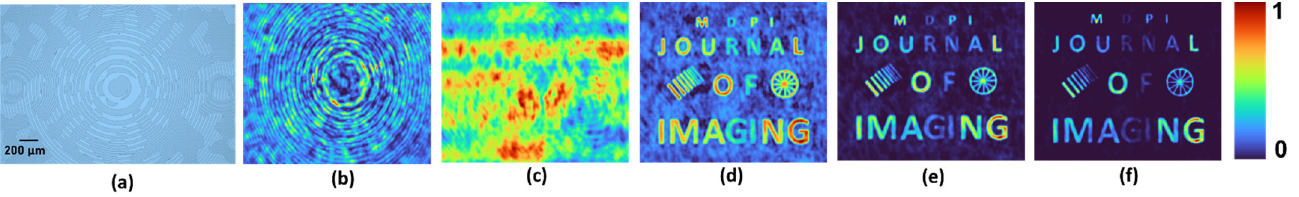
Figure 16. ( a ) Phase image of the multifunctional DOE. ( b ) Recorded PSF, ( c ) object’s response pat- tern. Reconstruction results using ( d ) NLR ( p = 1), ( e ) NLR ( p = 2) and ( f ) NLR ( p = 3) for double- helix beam with rotating PSF. 5. Discussion and Conclusions The optical fields that were simulated and experimentally generated in the previous sections are widely used for various applications such as optical trapping (Laguerre– Gaussian beams), 3D fabrication (Bessel beam), corneal surgery (Lens–axicon pair) and imaging through occlusion and turbid media (Bessel and accelerating Airy beams). Most, if not all, the light–matter interactions have been observed using another optical channel, which is the imaging channel. The proposed direction of research using the above deter- ministic optical beams in an indirect-imaging framework may compactify the future opti- cal systems by avoiding the imaging channel. It is convincing from the simulation and previous experimental studies [2,27,28,30–35] that the NLR, and raising the image to a power of p , can reconstruct a high-contrast object’s image faithfully and at the same time act as a spectral and spatial confocal system. Raising the image to a power of p improved the visibility with a slight decrease in the greyscale profile. With the latest developments in deep-learning-based image enhancement, we believe that NLR, and raising the image to a power of p and deep-learning methods, can act as a universal reconstruction method for imaging in indirect-imaging framework in the future [54]. In this review, we have investigated several known optical apertures that have the potential for different applications in the indirect-imaging framework using NLR. Simu- lation and experimental results indicate that NLR is a universal reconstruction method when combined with raising the image to a power of p ( p is an integer equal to or greater